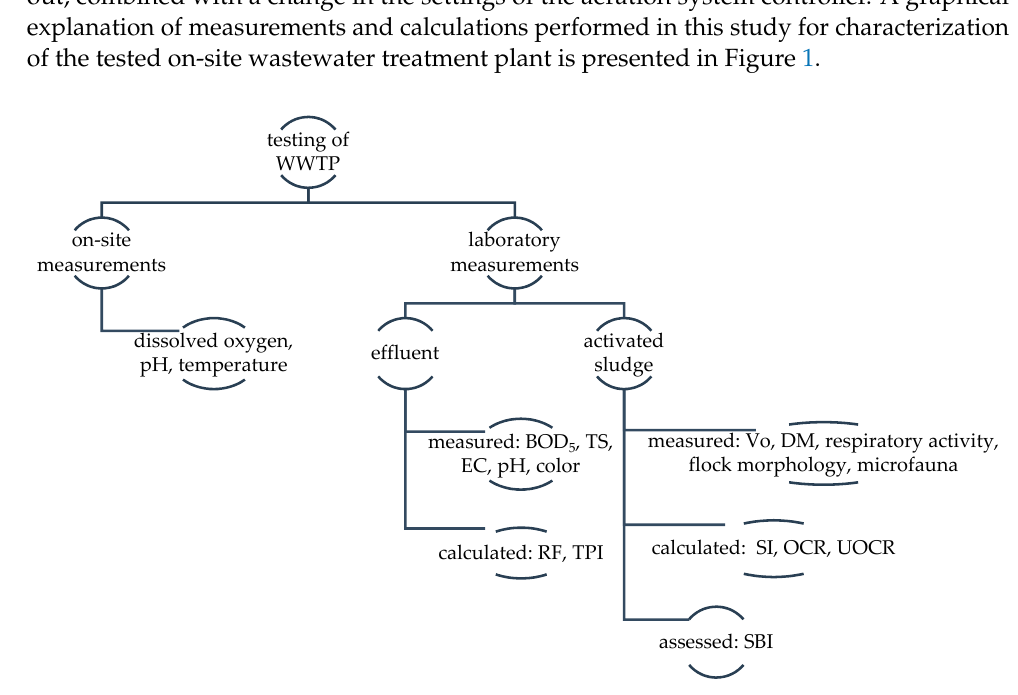
Figure 1. Testing protocol for on-site wastewater treatment plant (WWTP) used in this